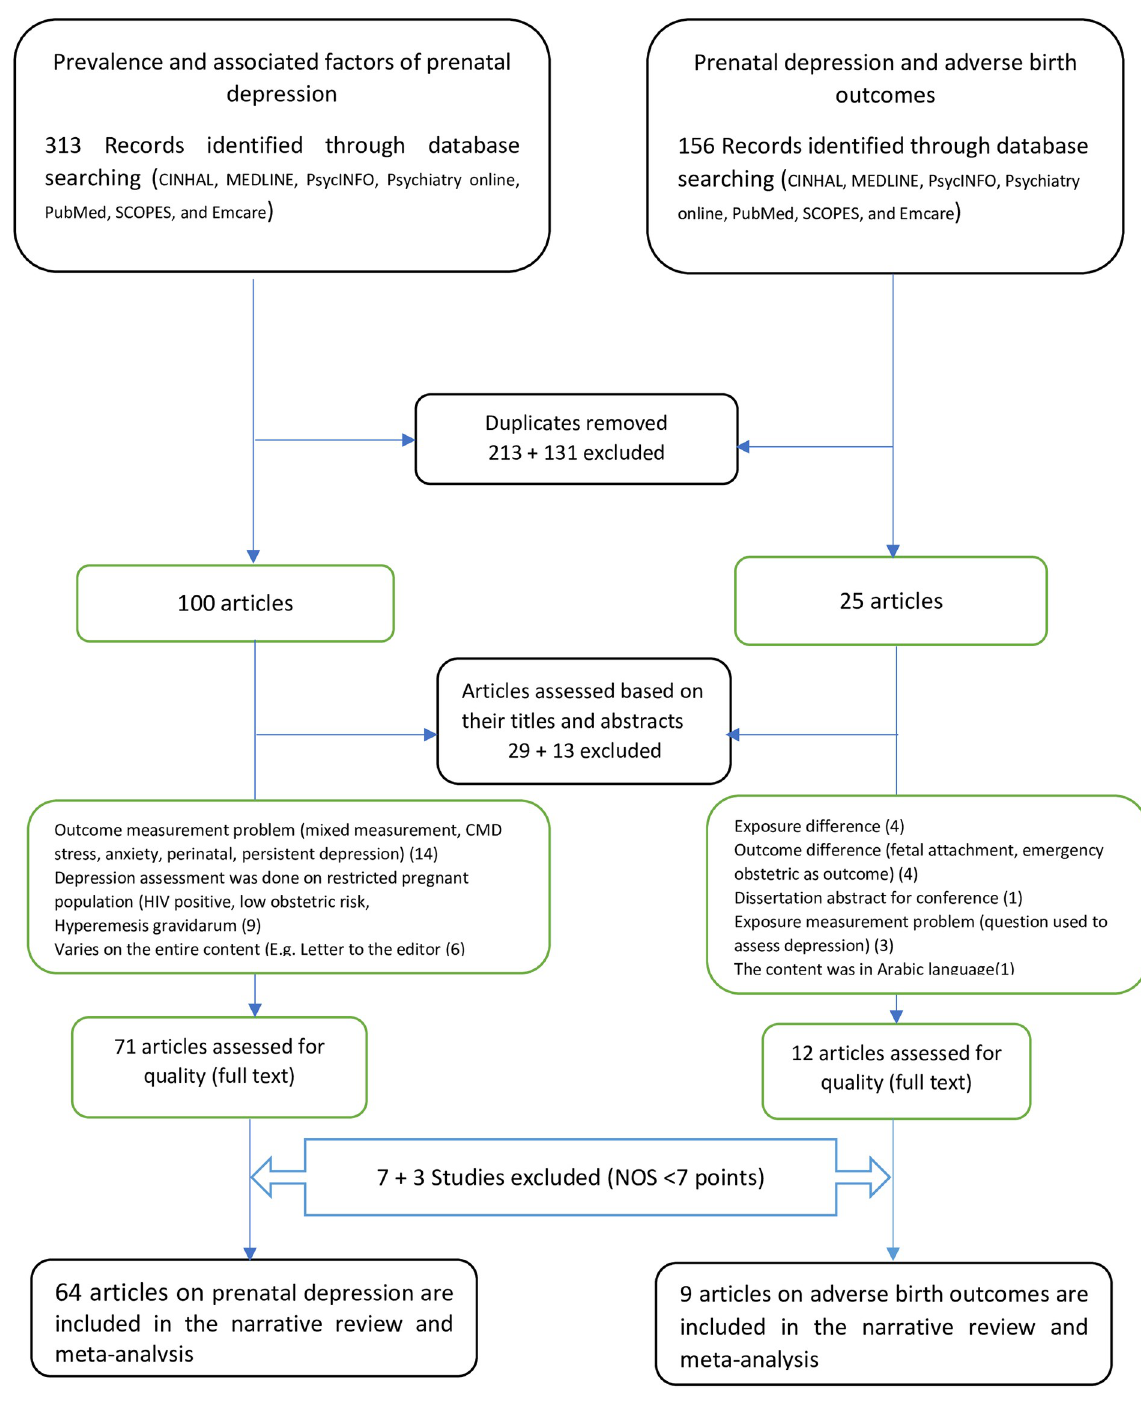
Fig 1. Flow chart of study inclusion for systematic review and meta-analysis of antenatal depression and its effect on birth outcomes.